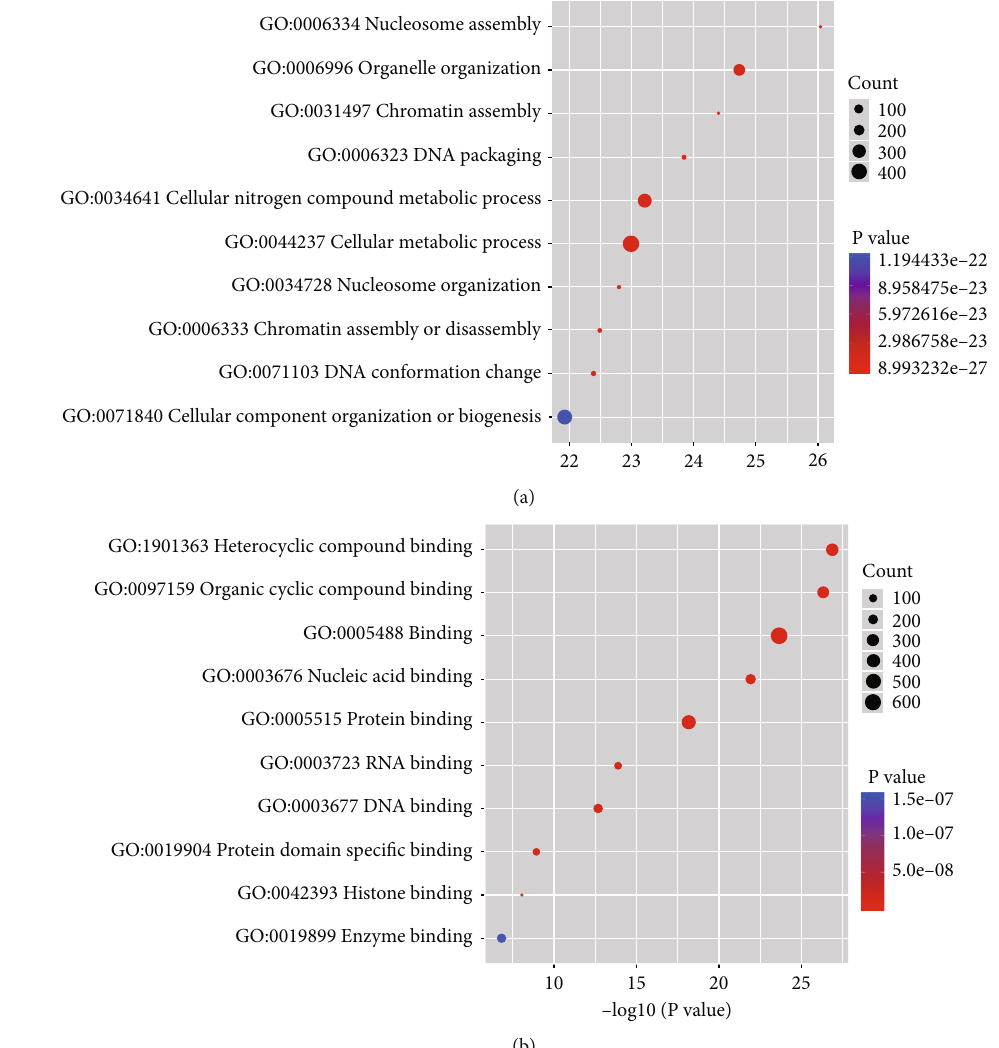
Figure 3: Gene Ontology analysis based on promoter-centered annotation. GO enrichment analysis on peaks which were located within -2 kb to +2kb around the corresponding gene TSS. (a) The top ten enriched biological processes were shown. (b) The top ten enriched molecular functions were shown.